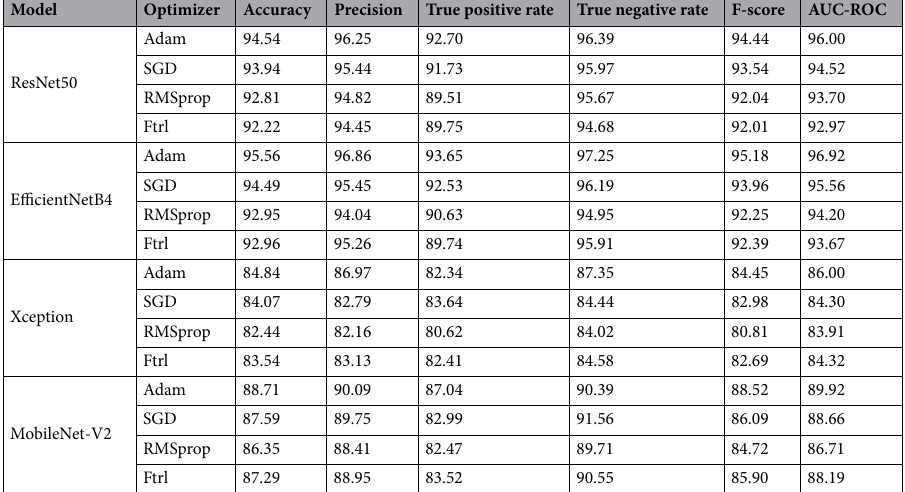
Table 1. Statistical fitness metrics of the residual network (ResNet), Xception, EfficientNetB4, and MobileNetV2 pre-trained conventional neural network (CNN) models in the detection of rust disease on sunflower, dry bean, and field pea using Adaptive Moment Estimation (Adam), Follow The Regularized Leader (Ftrl), Stochastic Gradient Descent (SGD), and Root Mean Square Propagation (RMSprop) optimizers. AUC- ROC = area under the receiver operating characteristic curve. All units are in